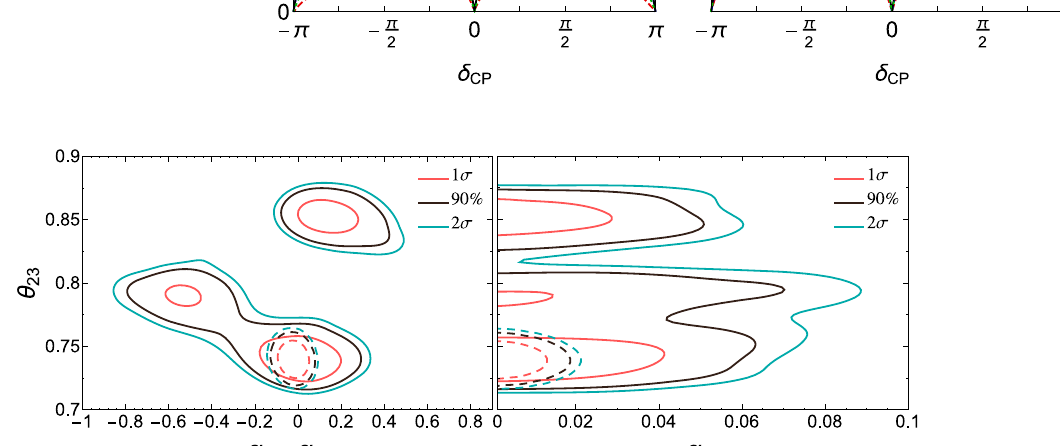
0 . 235 π ≈ 0 . 738 rad is assumed. The solid lines correspond to the anal- ysis of DUNE data alone, while the dashed lines include the present constraints on non-unitarity. The values of θ 23 are shown in